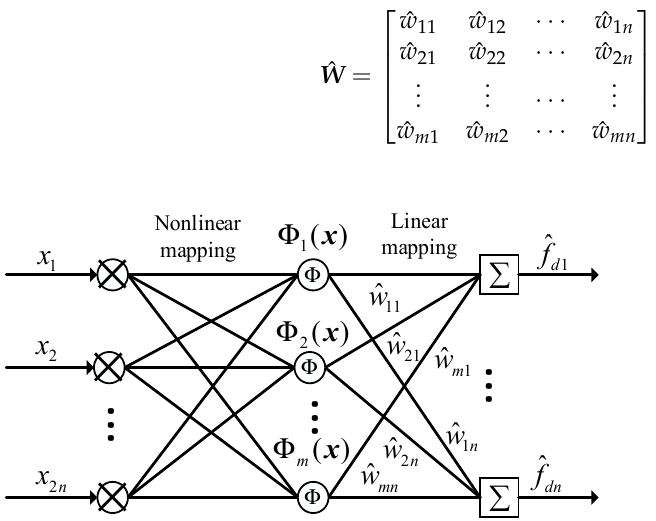
Figure 4. The structure of RBFNN.